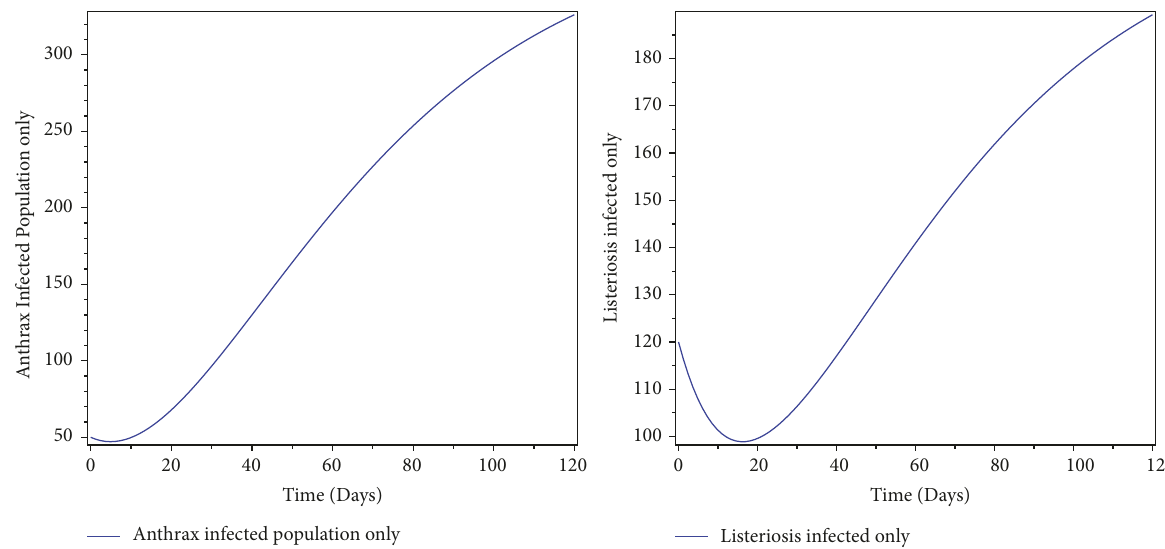
Figure 6: Simulation showing infected Anthrax and infected Listeriosis population.